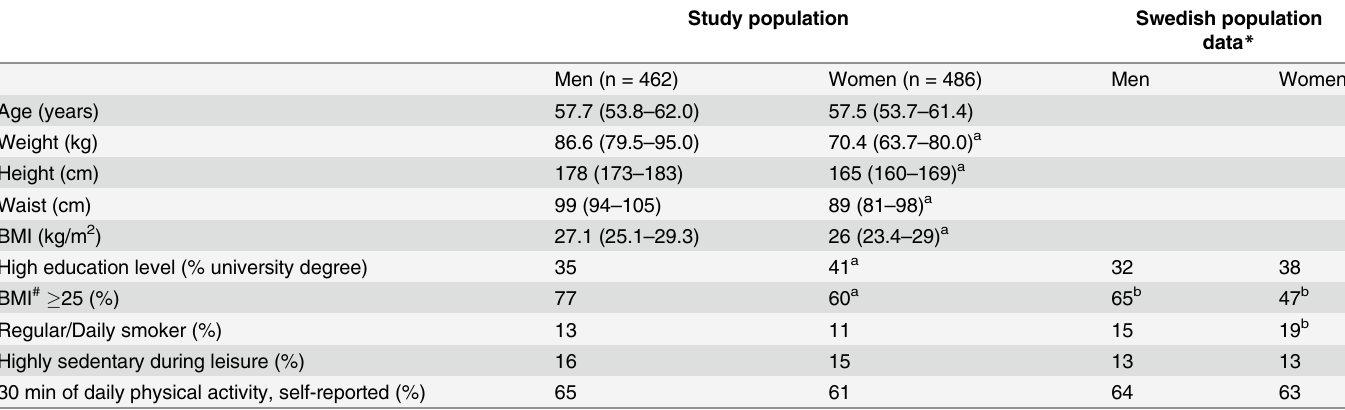
Table 1. Characteristics of the study population and Swedish population data with regard to gender.